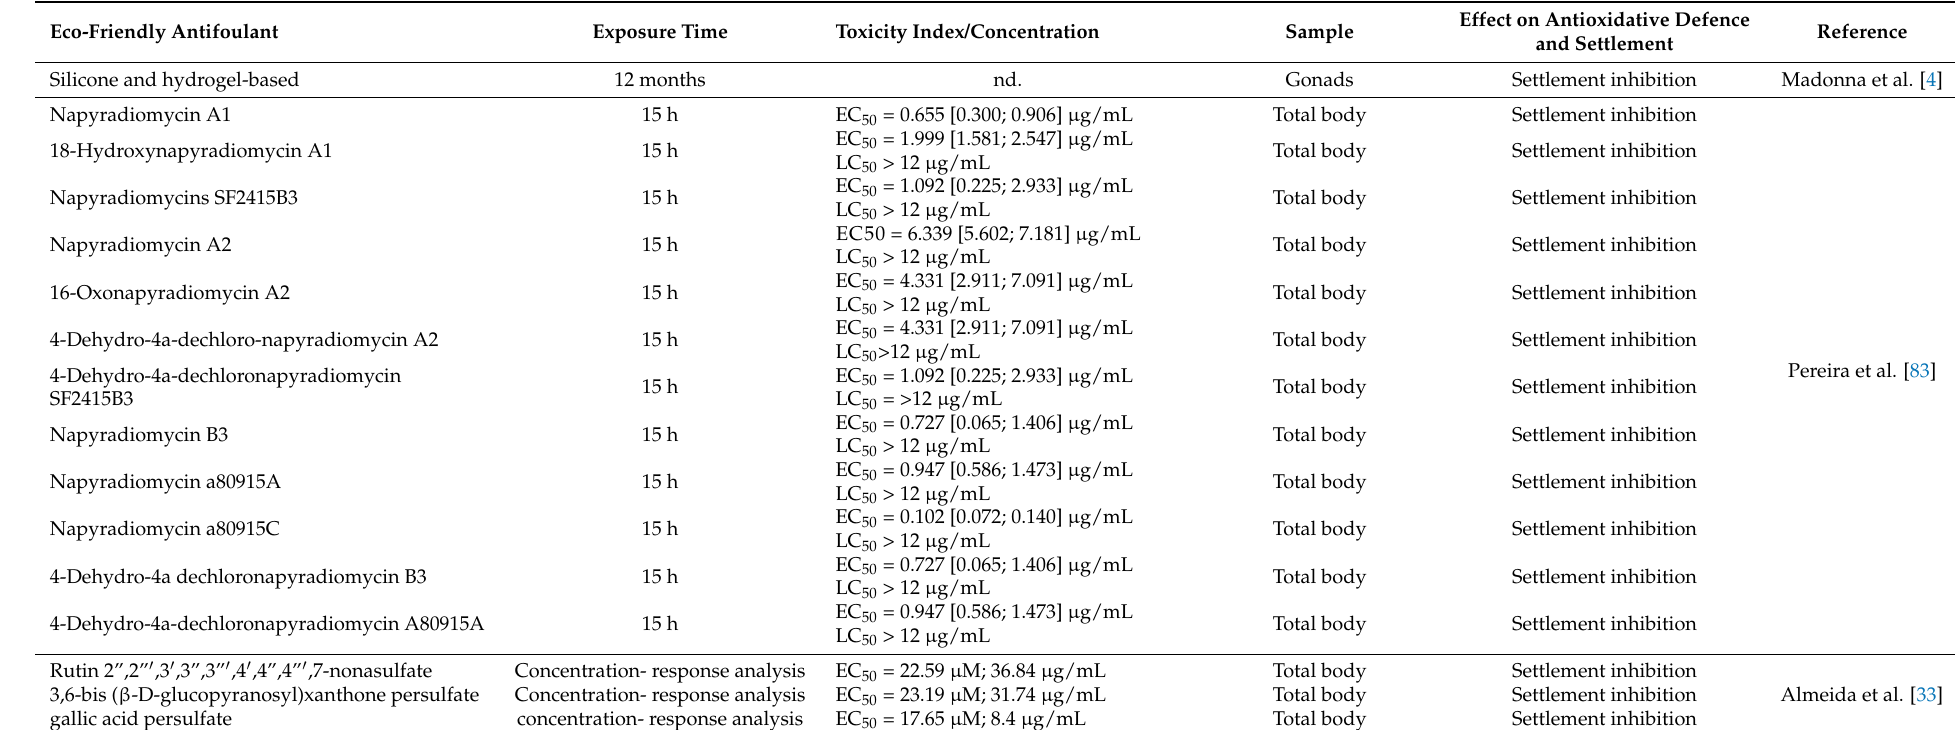
Table 2. Summarized results and data references for eco-friendly antifoulants occurring in Mytilus galloprovincialis . Eco-Friendly